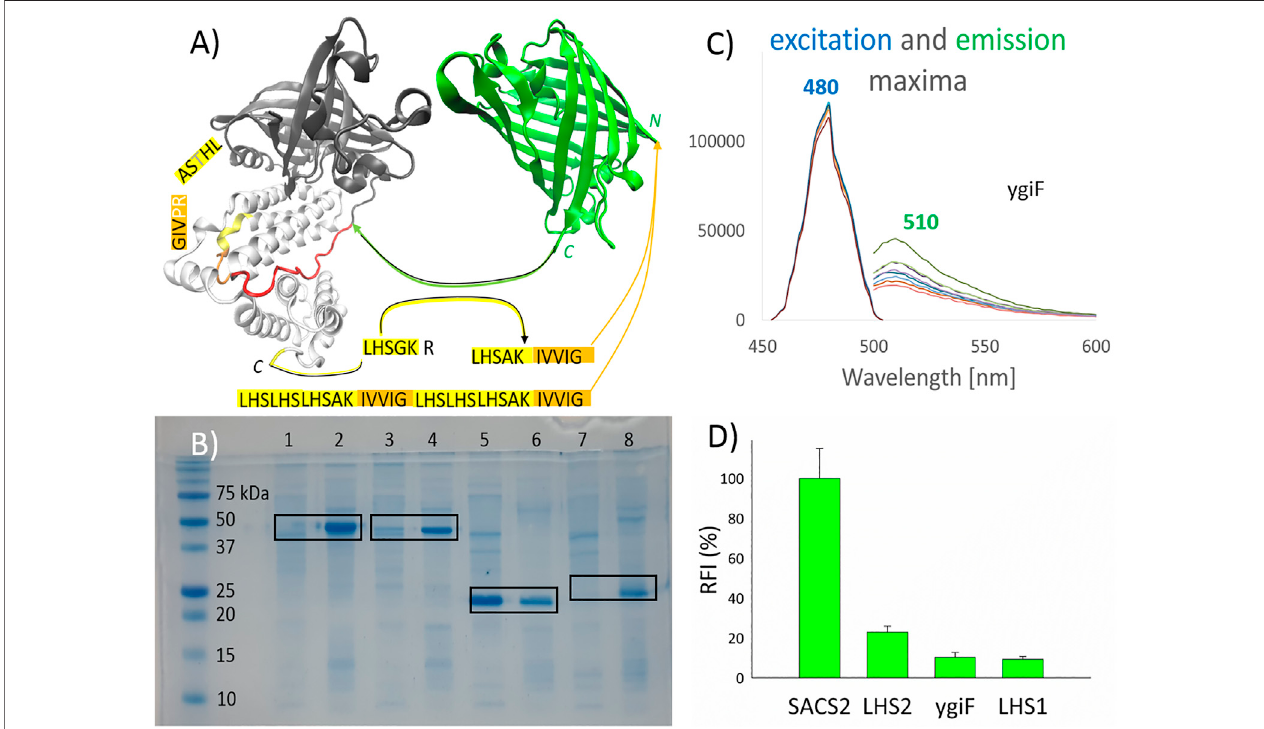
FIGURE 1 | Pull-down into active inclusion bodies. (A) ygiF inorganic (poly)-phosphatase from Escherichia coli . Tunnel metalloenzyme catalytic domain (TTM, black); polyP binding CHAD domain (white); and the used linker (red) are shown. TurboGFP (green), with its C - terminus connected to the linker. PolyP recognition sequences (yellow) were fused with a minimum hydrophobic sequence (orange) and attached to the N - terminus of turboGFP. The graphical illustrations and the sequences of the constructs are shown in the supplementary information (Supplementary Material) . (B) Sodium dodecyl sulfate polyacrylamide gel electrophoresis. Lanes 1/2, SACS2 construct supernatant/sediment; lanes 3 and 4, ygiF construct supernatant/sediment; lanes 5 and 6, LHS1 construct supernatant/ sediment;lanes7and8,LHS2constructsupernatant/sediment.Thesupernatant ofthecelllysateandthewashedsedimentofthecelllysate (aIBs)weredilutedequally. (C) The excitation and emission maxima of ygiF aIBs (PPi gradient, no metal presence). (D) The relative fl uorescence activity (RFI) of